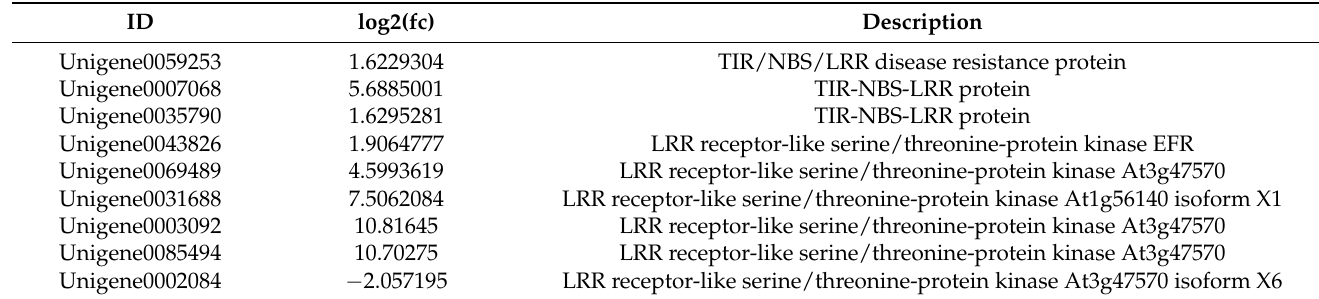
Table 3. Screening of differential R genes.